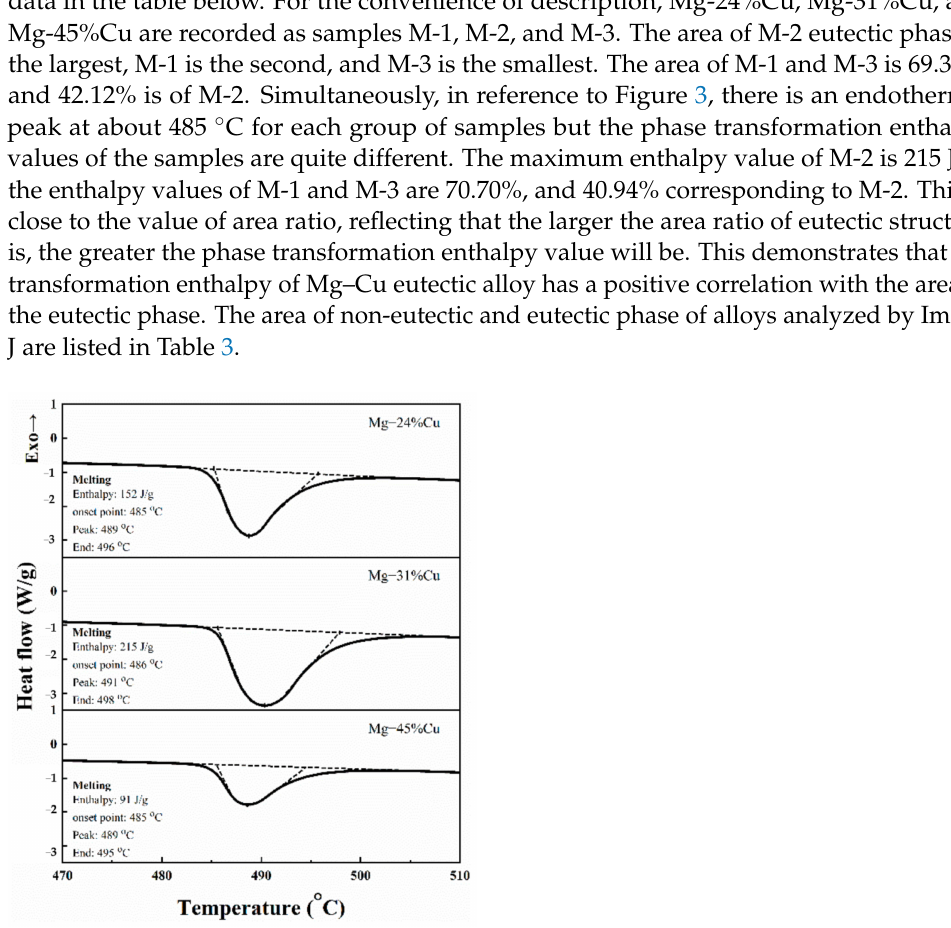
Figure 3. Phase change temperatures and enthalpies of Mg–Cu eutectic alloys: Mg-24%Cu, Mg- 31%Cu, and